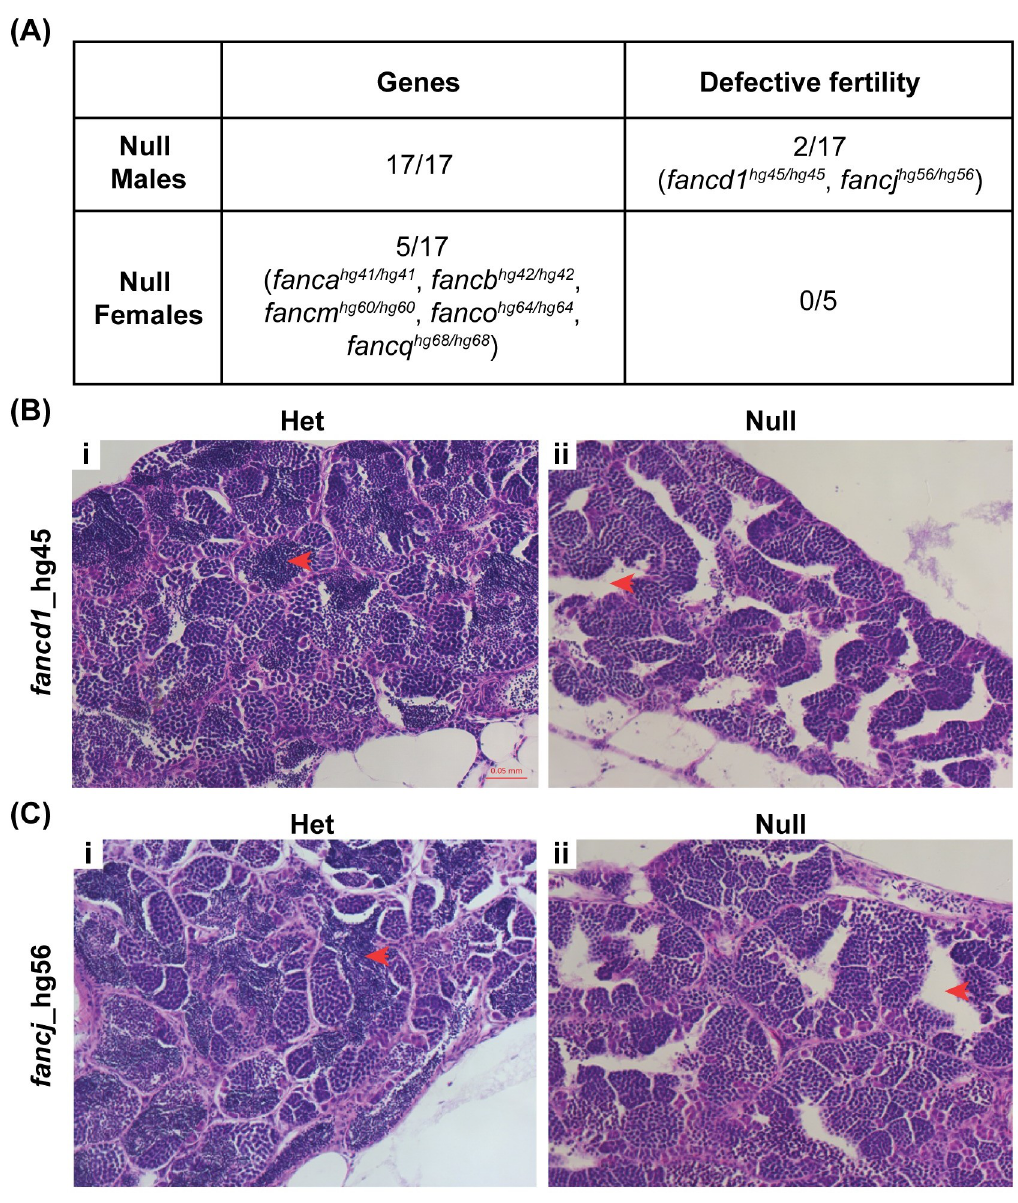
Fig 7. Homozygous knockout fish are fertile except for fancd1 and fancj knockout males. (A) Viability of embryos from outbred homozygous knockout fish at 24 hpf was determined to assess their fertility. Except fancd1 and fancj knockout males, all other knockouts (both males and females) had no fertility defect. For fancd1 hg45/hg45 a small fraction of embryos ( < 5%) were found viable at 24 hpf. (B-C) Histology images (20x objective) of hematoxylin and eosin stained adult testis of fancd1 hg45/hg45 (B) and fancj hg56/hg56 fish (C). The red arrows point to the area where mature spermatozoa reside in the testis. Empty intra- testicular ducts were observed in homozygous mutant testis (ii) but not in the heterozygous testis